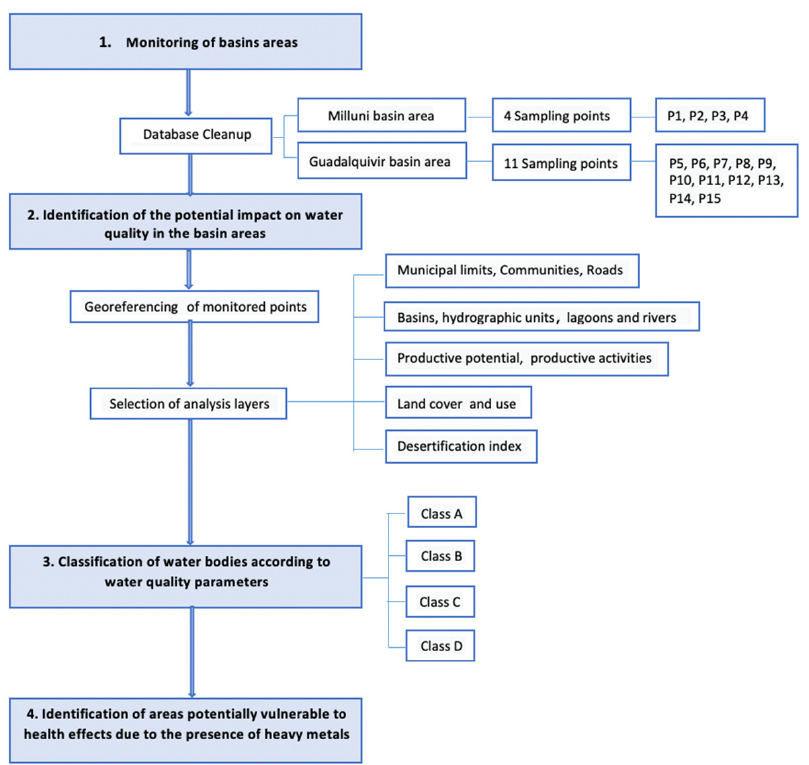
Figure 2. Methodological